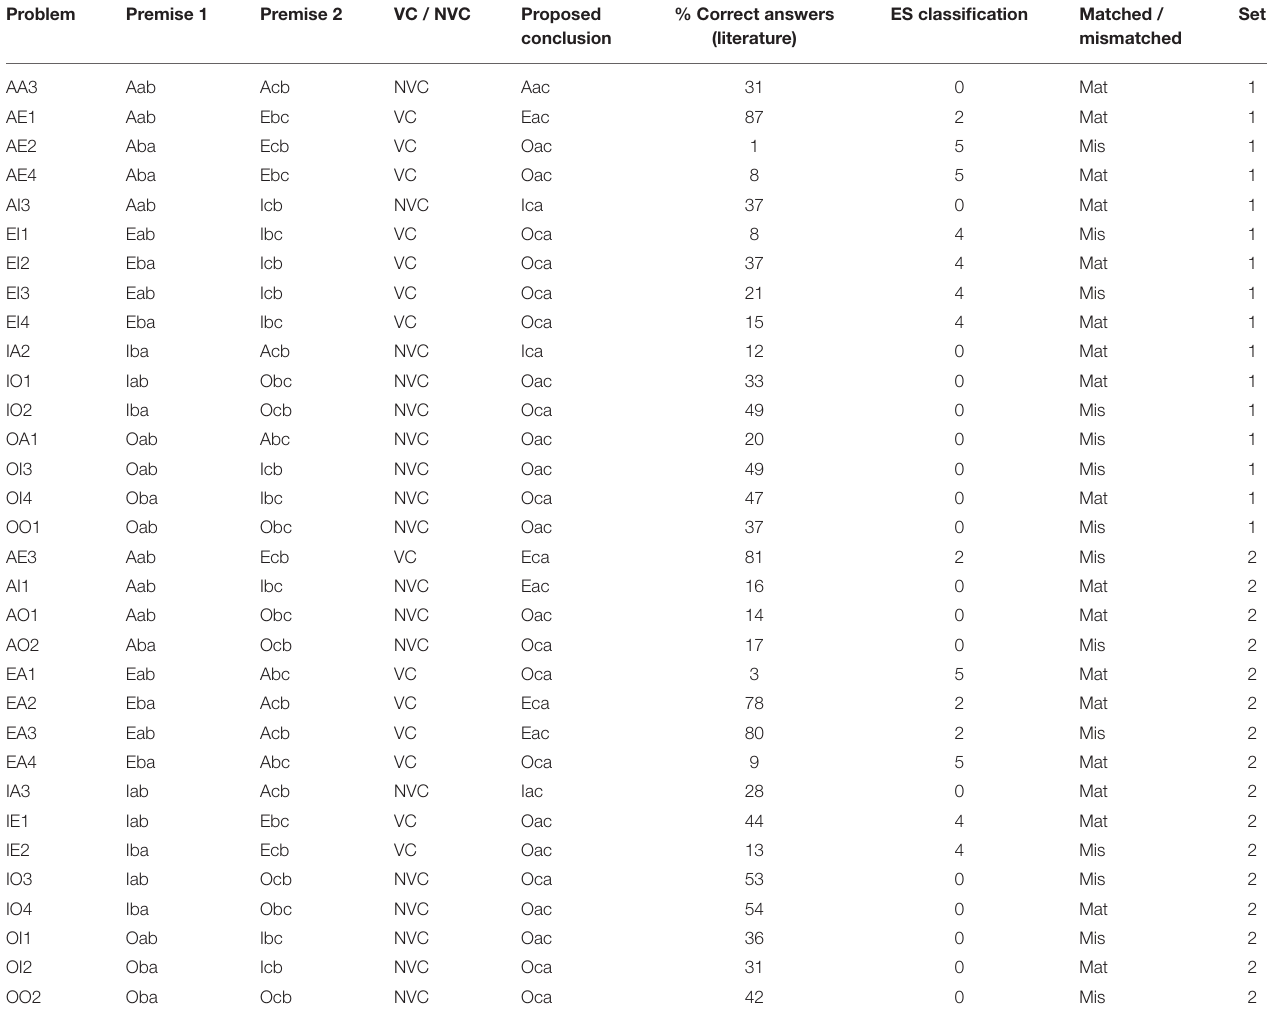
TABLE 1 | The 32 problems selected in the study, their premises, existence, or absence of valid conclusions, the proposed conclusions in the tasks following the evaluation paradigm, percentage of correct answers in the literature CV task, the ES classification, the matched vs. mismatched classification and our two sets